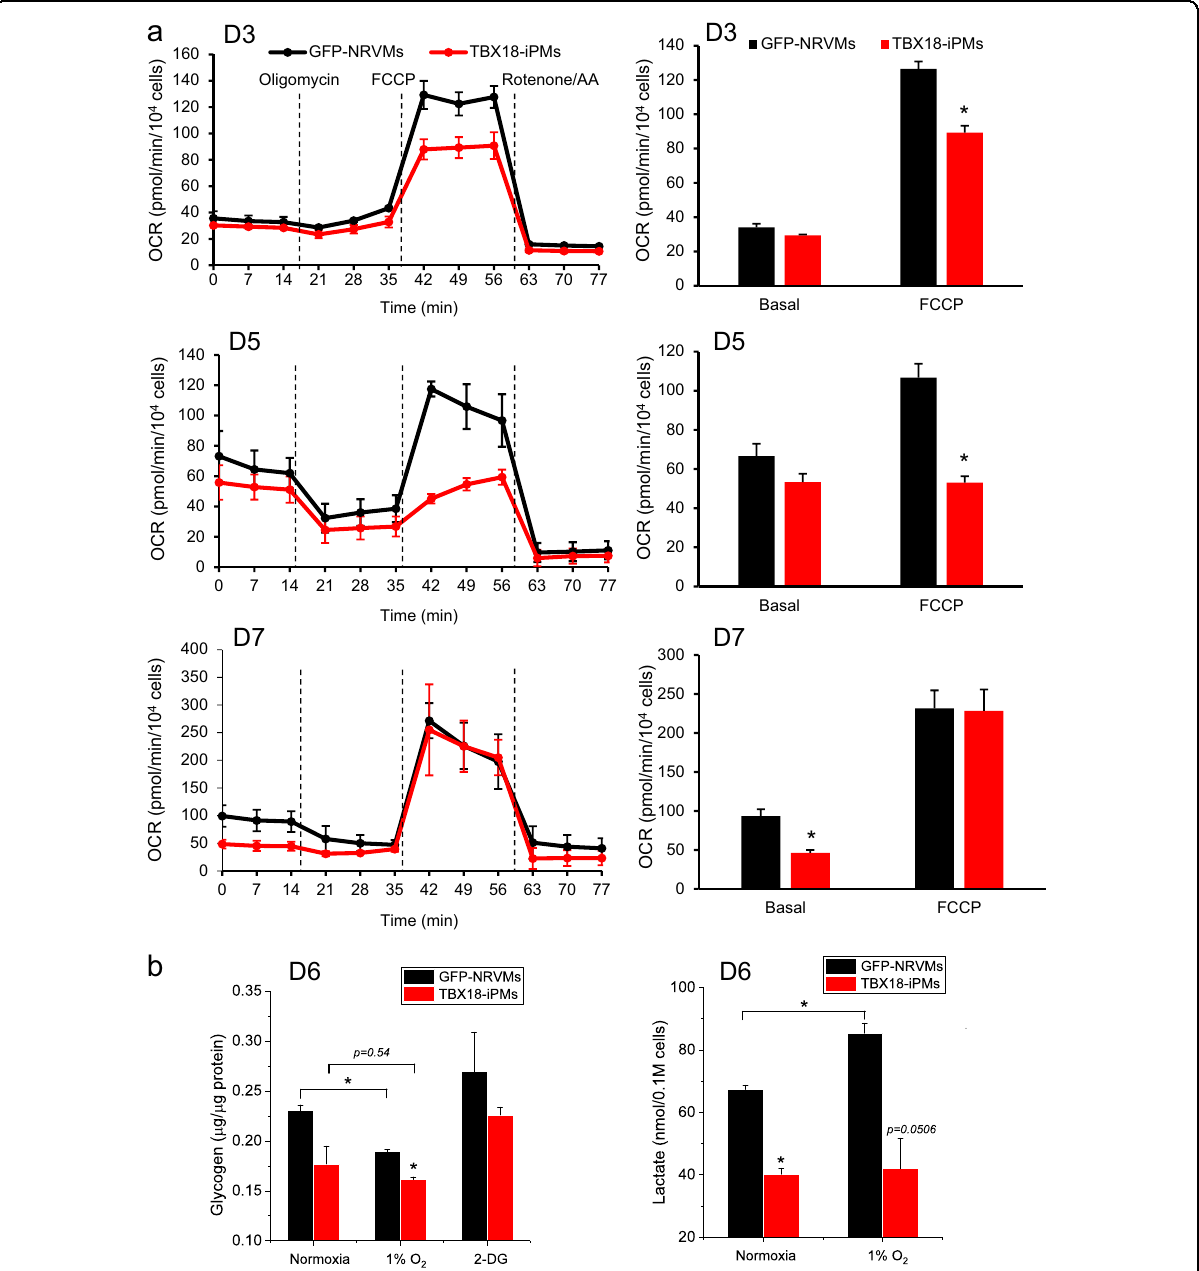
Fig. 3 TBX18-iPMs show a slower oxygen consumption rate and a lower glycolytic capacity. a Oxygen consumption rate (OCR) of TBX18-iPMs and GFP-NRVMs was measured with a SeaHorse XFp analyzer at baseline and after sequential treatments with oligomycin (an ATP-synthase inhibitor), FCCP (an uncoupler of mitochondrial oxidative phosphorylation), and rotenone/AA (an inhibitor of mitochondrial electron transport chain) on D3, D5, and D7. Basal and maximal OCR are plotted for each time point ( n = 6). b Glycogen contents were determined in the cell lysates of D6 TBX18-iPMs and GFP-NRVMs under normoxia, after 1 hour of incubation in 1% O 2 or upon treatment with 20 m M 2-deoxy- D -glucose (2-DG) ( n = 8). The lactate content in the media from D6 TBX18-iPMs and GFP-NRVMs was quantitated under normoxia or after incubating the myocytes in 1% O 2 for 1 hour ( n = 8). * p <